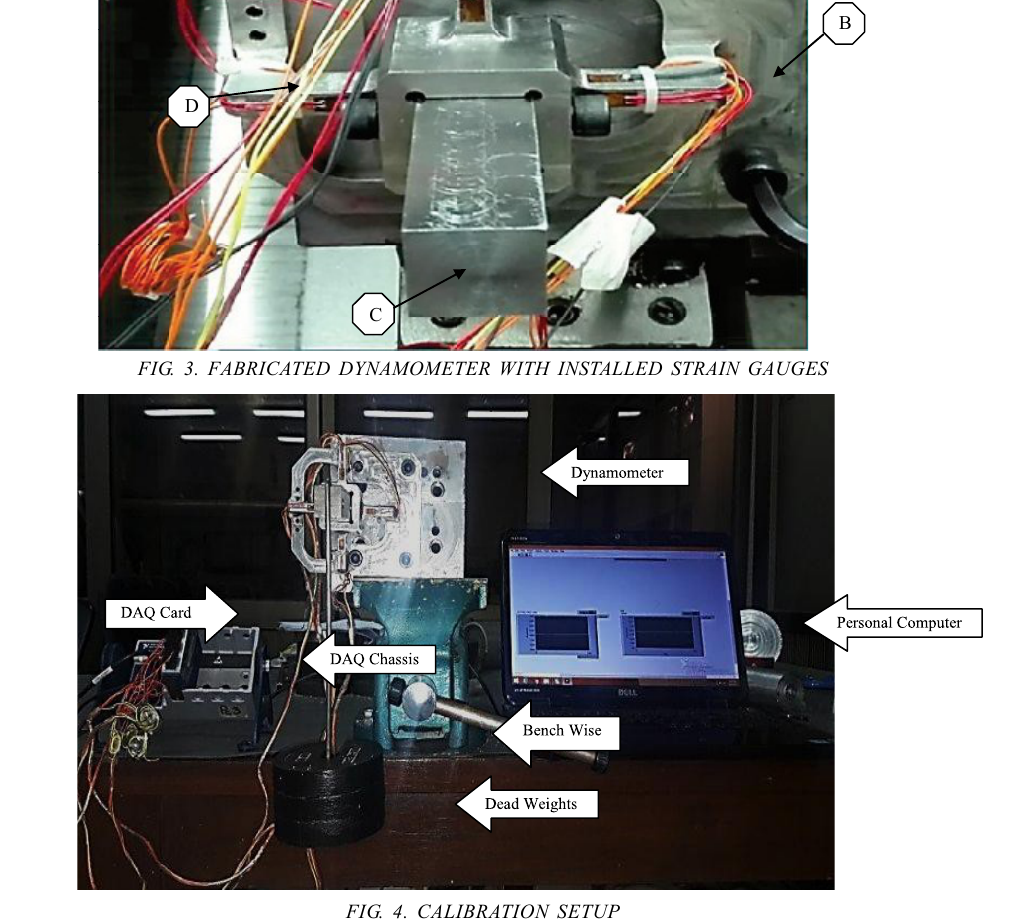
FIG. 4. CALIBRATION